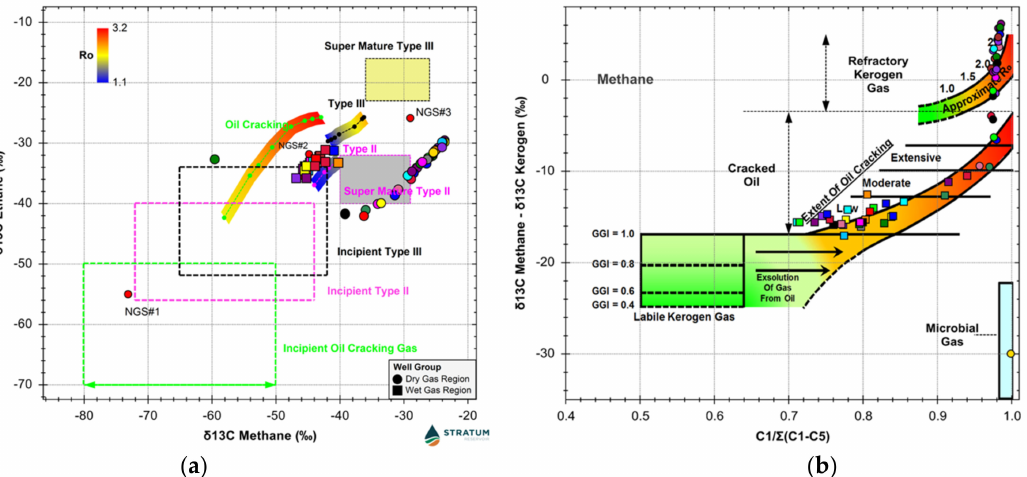
Figure 19. ( a ) Plot of methane δ 13 C versus ethane δ 13 C for produced Marcellus Formation natural gases. VR o maturity trends after Rooney et al. [40]. NGS#1, NGS#2, and NGS#3 are natural gas standards employed during isotopic analyses of the Marcellus samples. Wet gases lie between the fields for